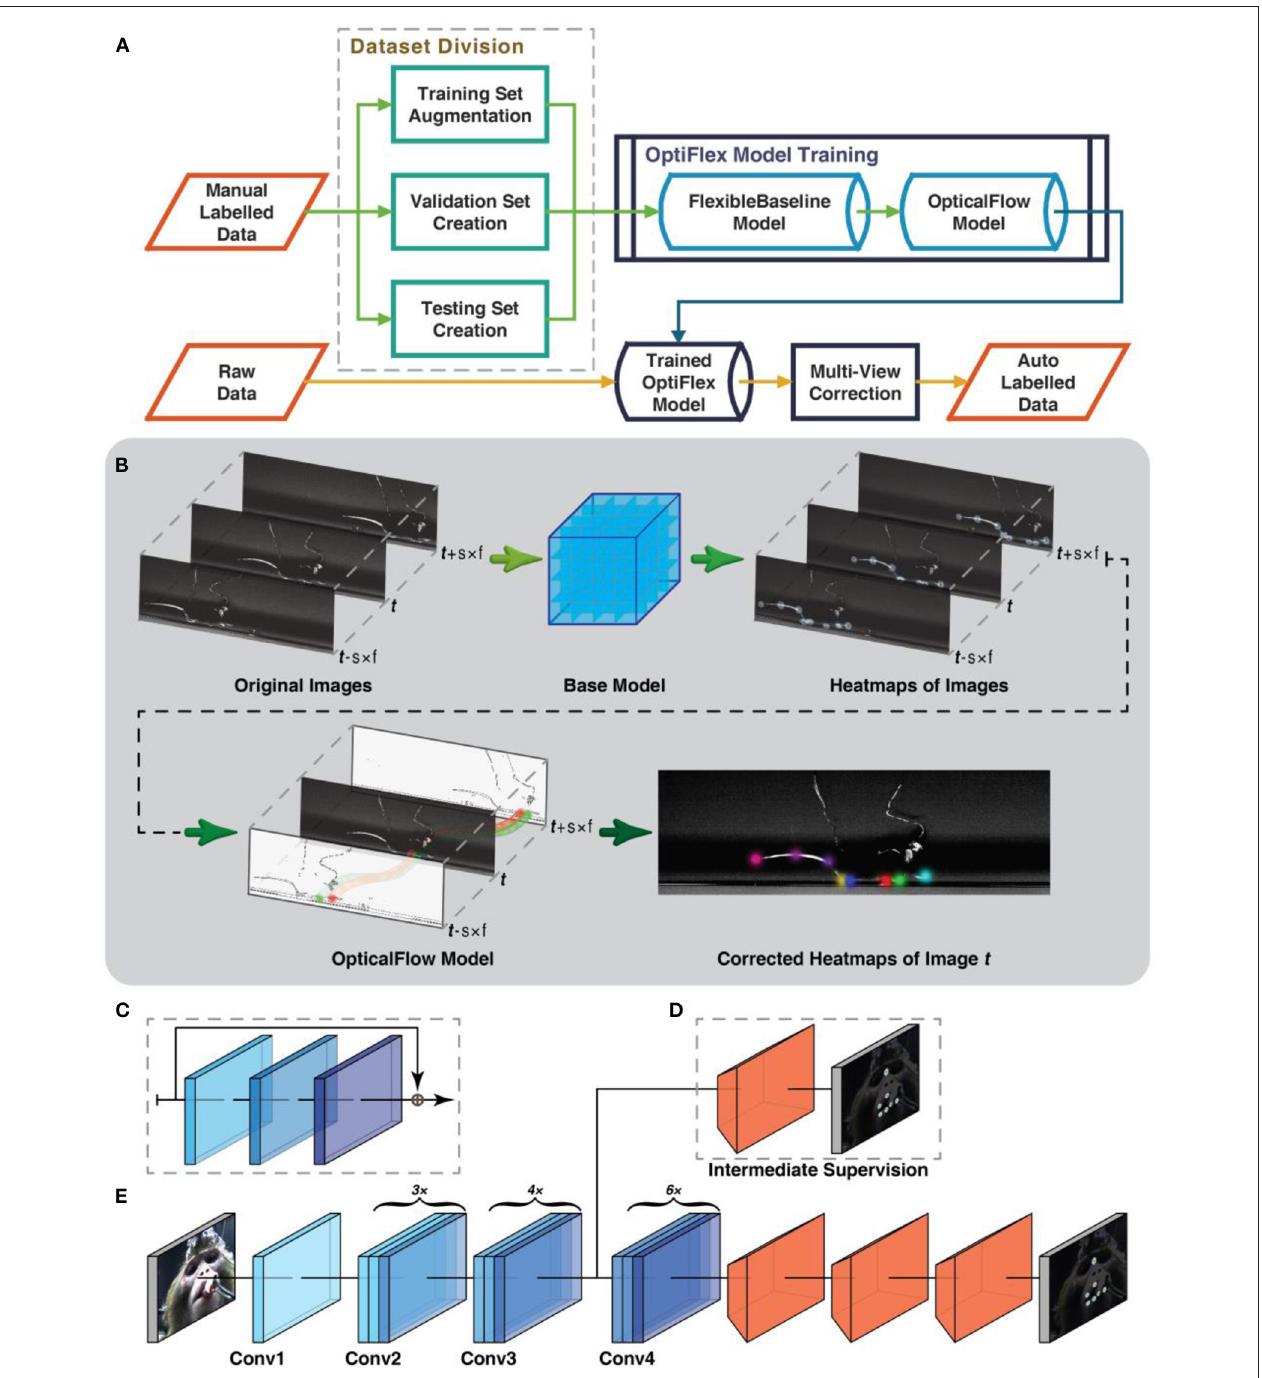
FIGURE 1 | Workflow and model architecture of OptiFlex. (A) Overall data preprocessing and model training pipeline. (B) Given a skip ratio s and frame range f . For a target frame with index t , we first gather a sequence of 2 f + 1 images with index from t − s × f to t + s × f . The base model makes a prediction on each of the images to create a sequence of heatmap tensors with index from t − s × f to t + s × f . The OpticalFlow model takes the entire sequence of heatmap tensors and outputs the final heatmap prediction for index t . (C) Diagram of a “bottleneck” building block commonly used in ResNet backbone, consisting of 3 convolutional layers and a skip connexion. (D) Optional intermediate supervision for FlexibleBaseline through an additional loss calculation between the heatmap label and intermediate results from ResNet backbone after a single transposed convolution as represented by orange trapezoidal blocks. (E) Standard FlexibleBaseline with intermediate supervision after the Conv3 block. Note that each Conv block consists of multiple (3x, 4x, or 6x) stacked “bottleneck” building blocks (see C ).